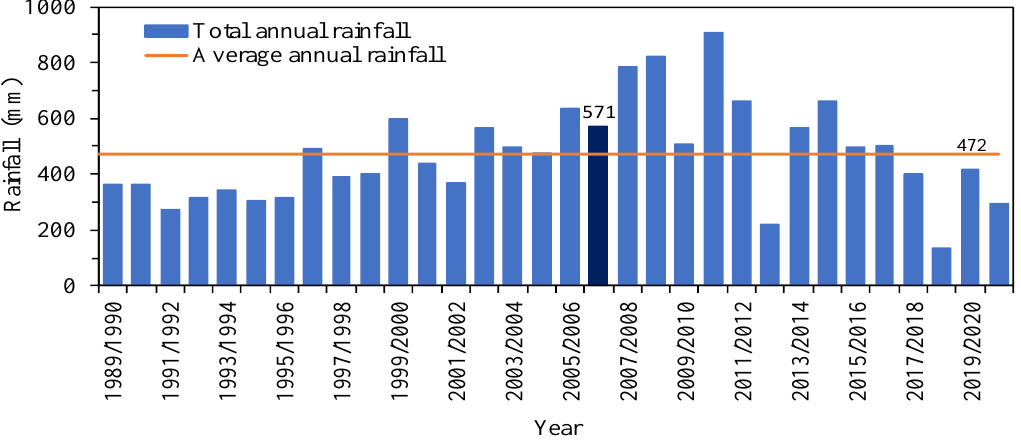
Figure 1. Annual rainfall patterns in North-Central Namibia from 1989/1990 to 2020/2021 highlighting the long-term average rainfall and experimental year, 2006/2007. Data source: Omahenene Research Station, Ministry of Agriculture, Water and Land Reform, Namibia.